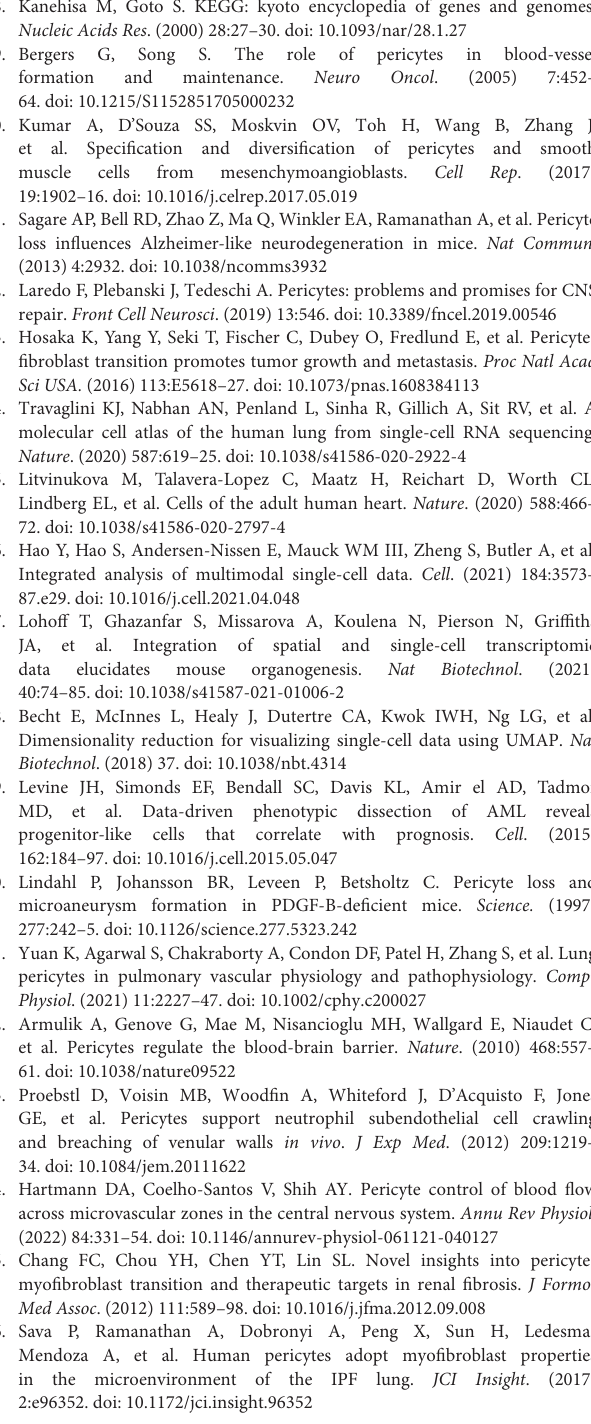
Supplementary Figure 7 | Expression levels of murine pericyte markers are identified in the human lung single cell RNAseq dataset. Density plot of the expression of human orthologs of potential pericyte markers identified from the mouse lung were further identified on the collection of the single cells of the Human Lung Cell Atlas.